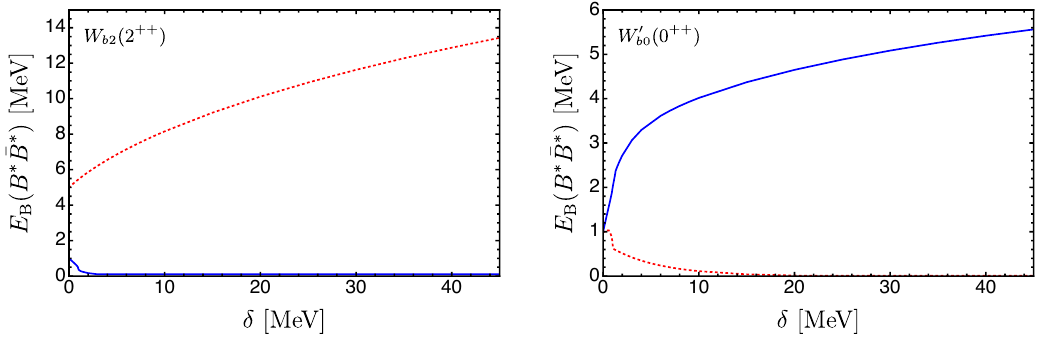
Figure 5 . Binding energies of the W b 2 (2 ++ ) and W 0 (0 ++ ) states versus the mass splitting (cid:14) for b 0 two di(cid:11)erent solutions for the contact terms in the pionless theory: the red dotted lines correspond to the (cid:12)rst solution discussed in section 4 while the blue solid lines represent the results of the alternative scenario with the interchanged contact terms (see the text for the further